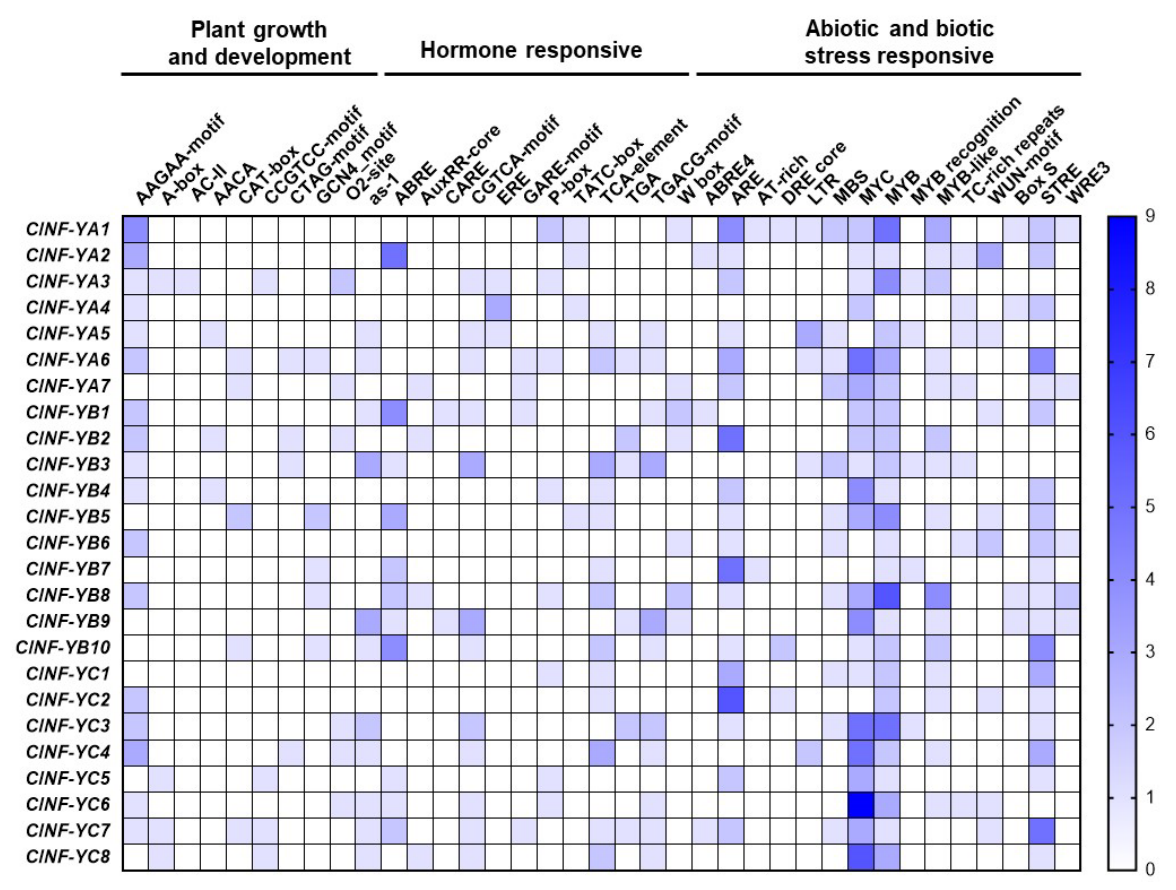
Figure 4. Cis -elements present in promoters of the watermelon ClNF-Y genes. Different colors indicate the numbers of the cis -elements in promoters of the ClNF-Y genes, as shown in the right color scale. See Table S3 for detail.